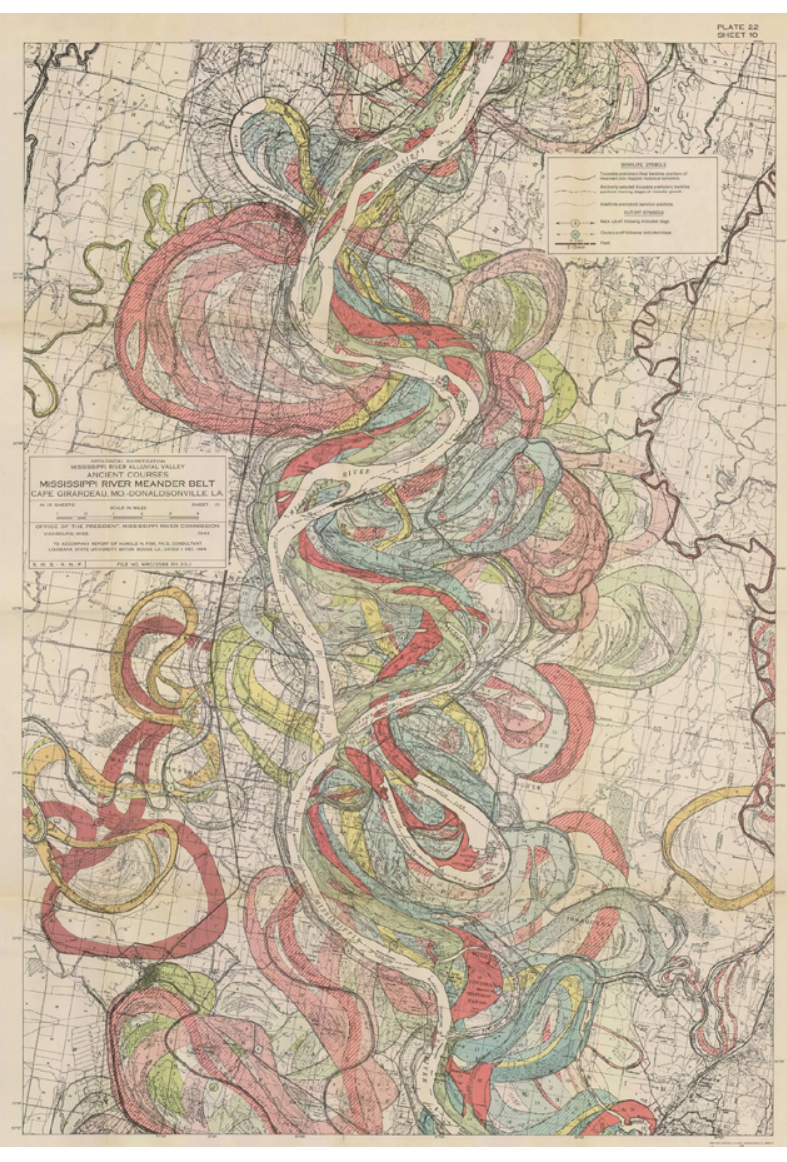
FIG. 6 Harold N. Fisk’s geological investigation of the alluvial valley of the lower Mississippi where each colour corresponds to a different period of the river path evolution, 1944. Source: Mississippi River Commission, Sheet no.